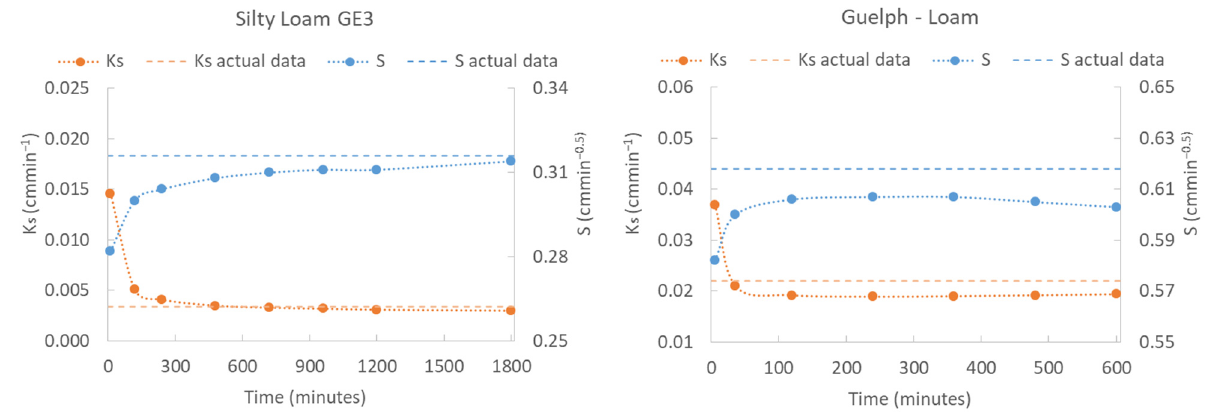
Figure 3. Measured K s and S values and the predicted ones from Equation (6), with respect to the time, for all porous media studied.